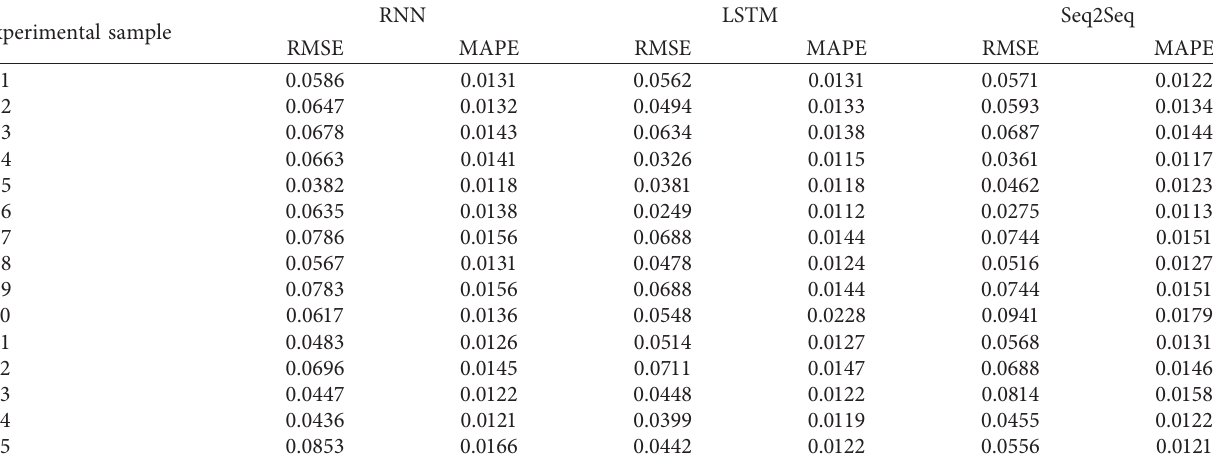
Table 2: Prediction results of three network models.